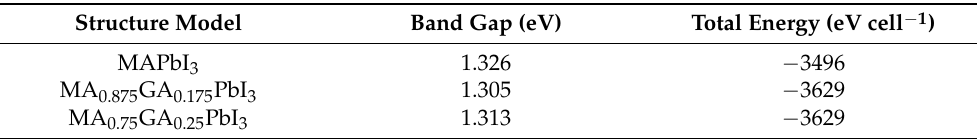
Figure 5. Electron density distribution of MA 0.875 GA 0.125 PbI 3 . Table 3. Band gap and total energies of MAPbI 3 , MA 0.875 GA 0.125 PbI 3 and MA 0.75 GA 0.25 PbI 3 by band